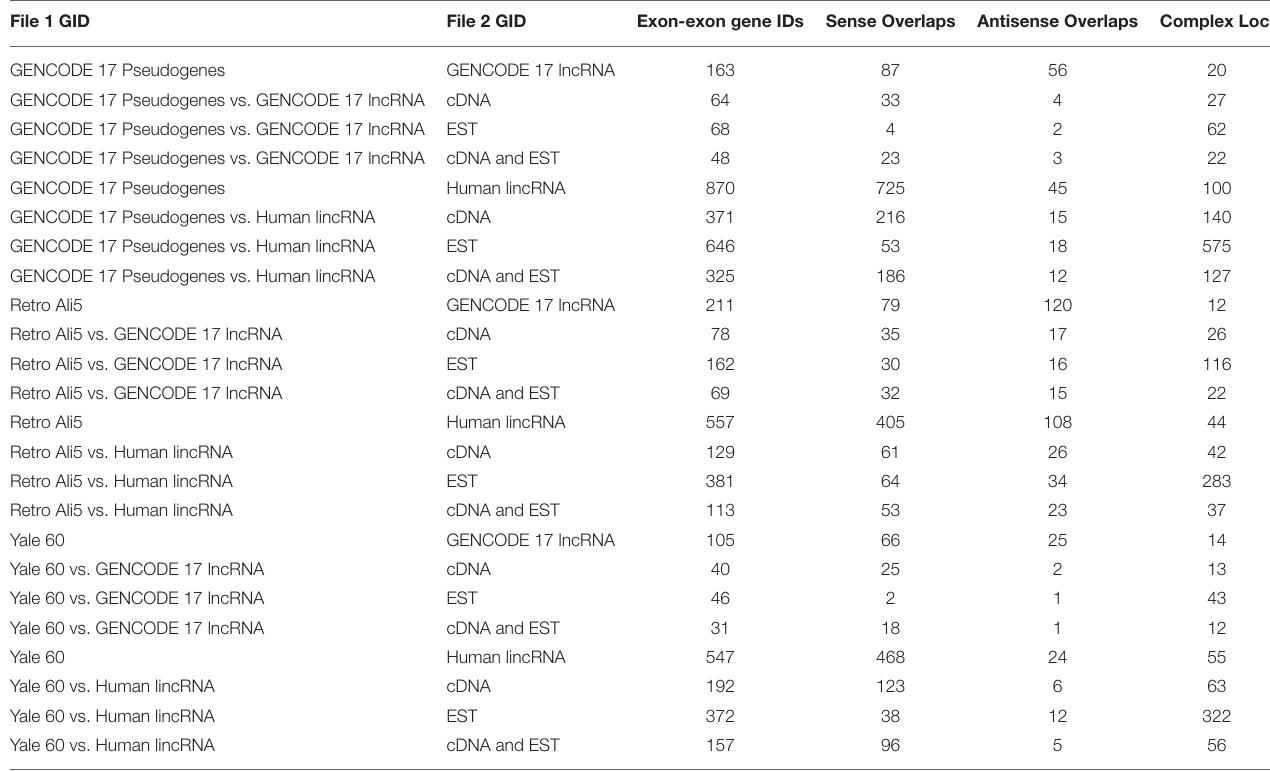
TABLE 1 | Computationally derived intersections of all pseudogene, lncRNA, cDNA, and EST databases.